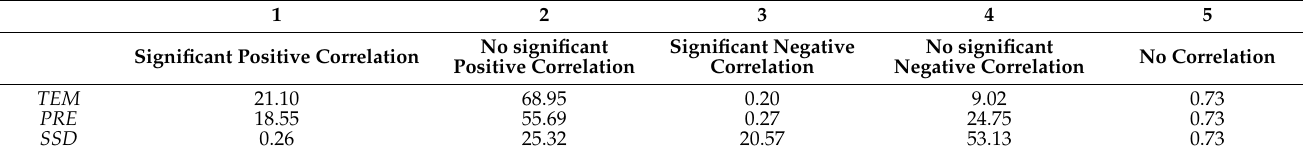
Figure 12. Spatial distribution of the correlation between annual FVC and climatic factors in the QBM from 2000–2020: ( a ) TEM; ( b ) PRE; ( c ) SSD. Table 10. Area proportion of correlation level between FVC and climate factors/%.